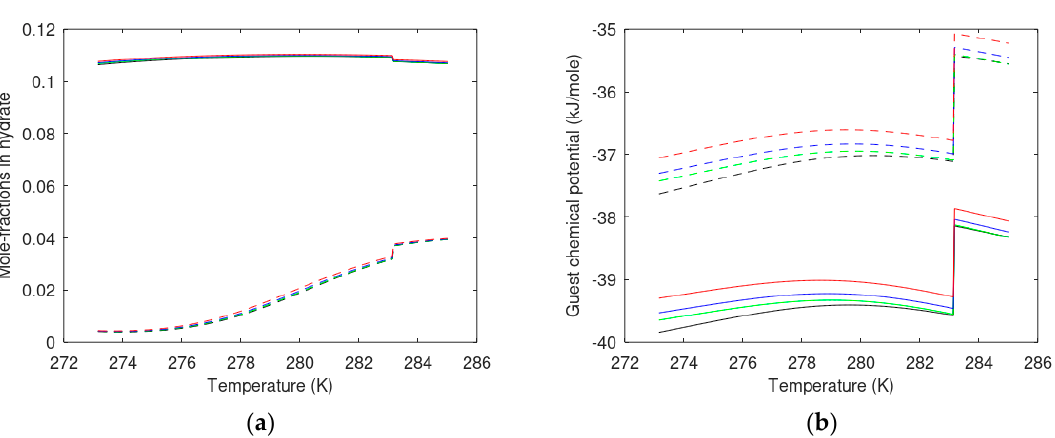
Figure 6. ( a ) Hydrate composition in mixed CO 2 /N 2 hydrate formed from a CO 2 /N 2 mixture containing 20 mole percent N 2 and water containing ethanol. Dashed curves are N 2 and solid curves are CO 2 . Black curves are for 0 mole-fraction ethanol, green curves are for 0.015 mole-fraction ethanol, blue curves are for 0.02 mole-fraction ethanol, and red curves are for 0.03 mole-fraction ethanol. ( b ) Chemical potentials for CO 2 (solid) and N 2 (dashed curves) in hydrates formed from a CO 2 /N 2 mixture with 20 mole percent N 2 and water containing various concentrations of ethanol. Color codes are the same as in Figure 6a.